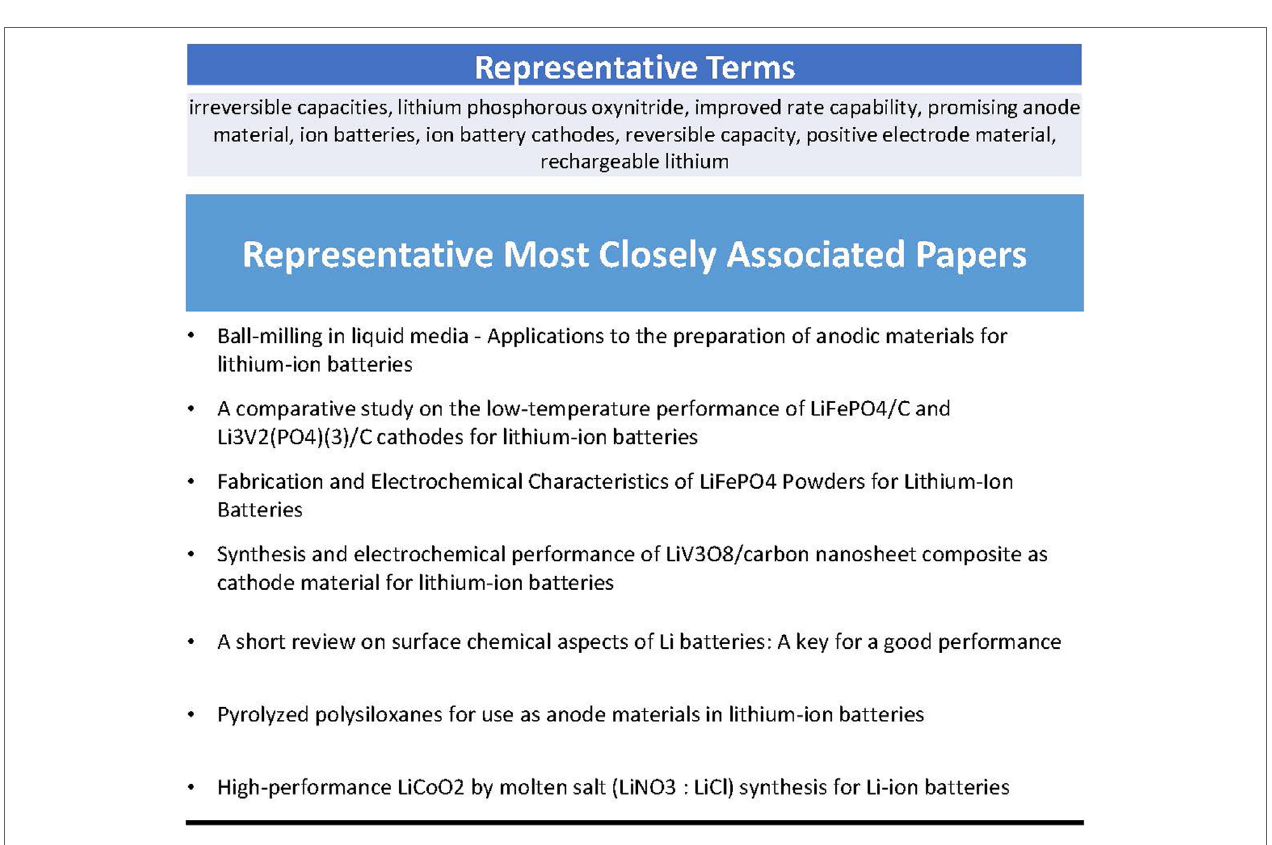
FigUre 3 | The coclustering algorithm produced term clusters. This is an example of a narrowly focused